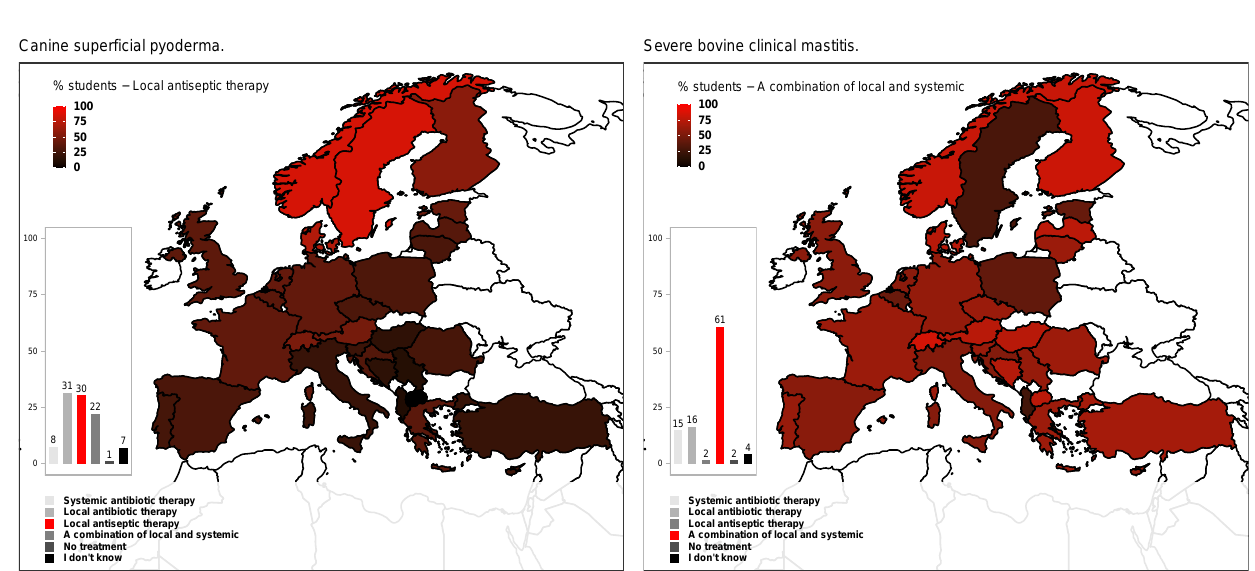
Figure 3. Treatment of choice by final year veterinary students in four clinical cases presented to them in question 20 of the survey: “Please indicate which treatment strategy you were taught to apply for the following infections”. Bar plots show the percentage of students selecting each of the answers available (bottom legends). Maps display the percentage of students that selected the answer specified in the top-left legends. Bar plots may display added percentages above or below 100% due to rounding of the